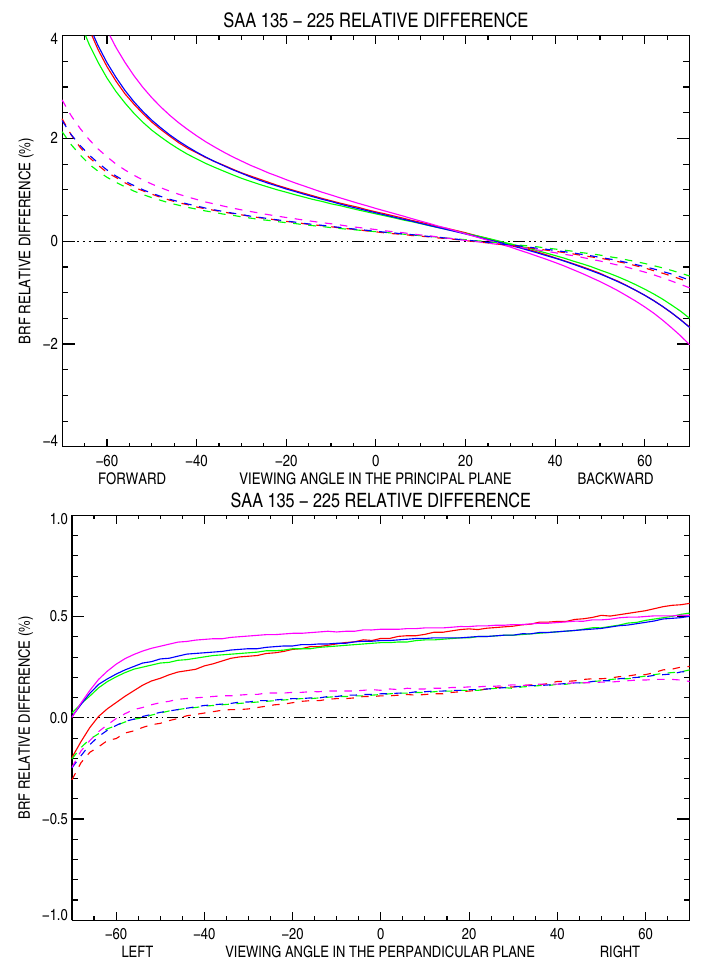
Figure 9. BRF relative difference between SAA 135 ◦ –225 ◦ in the principal plane ( top ) and the perpendicular one ( bottom ). Solid lines are for SZA = 50 ◦ and dashed lines are for SZA = 25 ◦ over the four ROIs: 10 × 10 km (red line), 20 × 20 km (green line), 50 × 50 km (blue line) and 100 × 100 km (magenta line). Sand reflectance is set to